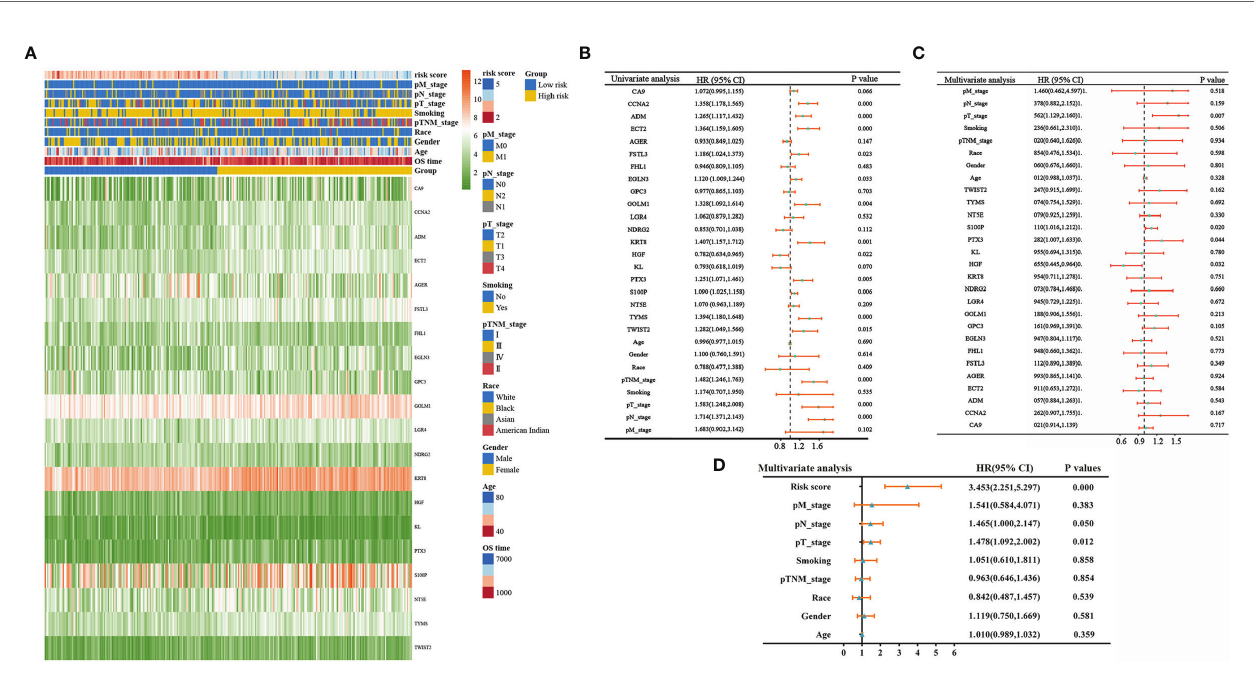
FIGURE 3 | Clinicopathological characteristics of different risk score groupings. (A) Heatmap showing clinicopathological characteristics of different risk score subgroups; (B) forest plot showing single-factor COX regression analysis gene signature; (C) forest plot showing multifactor COX regression analysis gene signature; (D) forest plot showing multifactor COX regression analysis risk